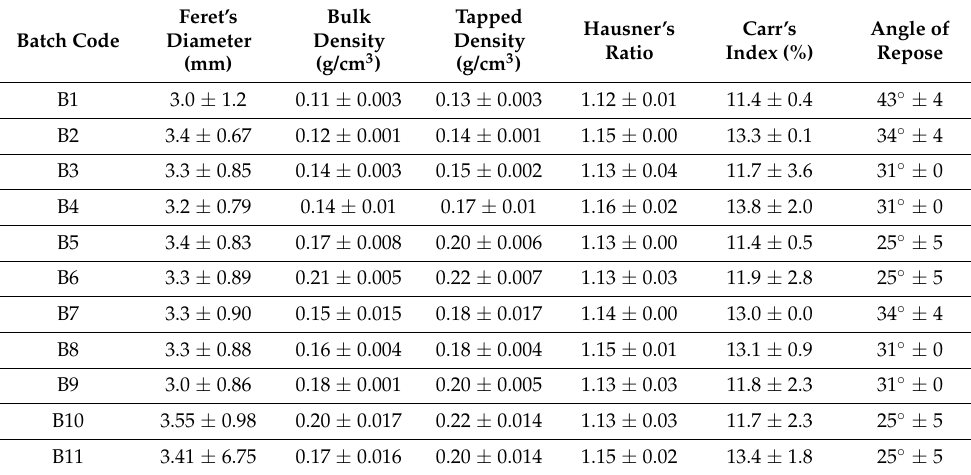
Table 2. Physico-chemical properties of the different paper granules produced in this